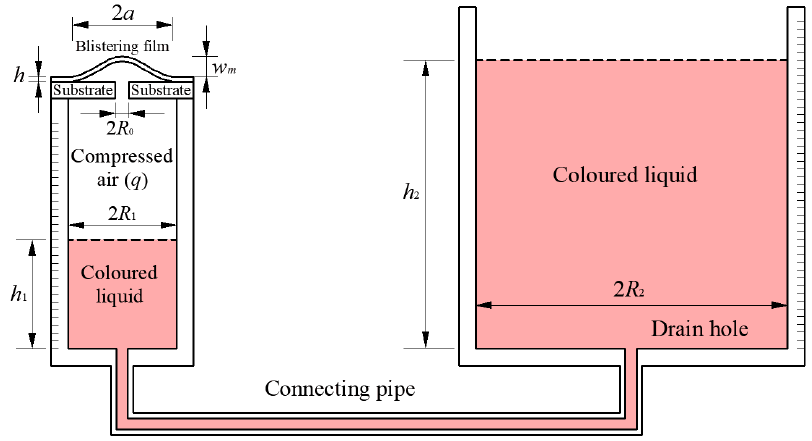
Figure 2. Schematic view of the experimental setup for pressurized blister test [9].